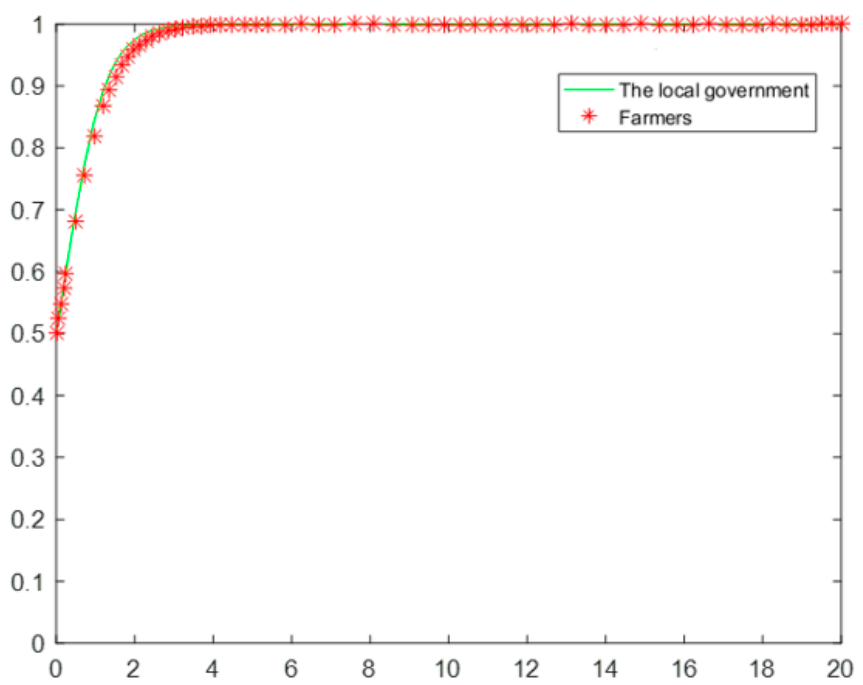
Figure 6. Evolution of strategic choice between local governments and farmers in the case of harmonious expropriation.